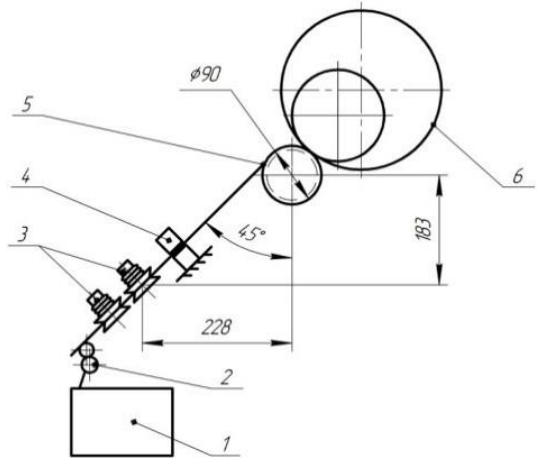
Fig. 2. Process scheme of the developed